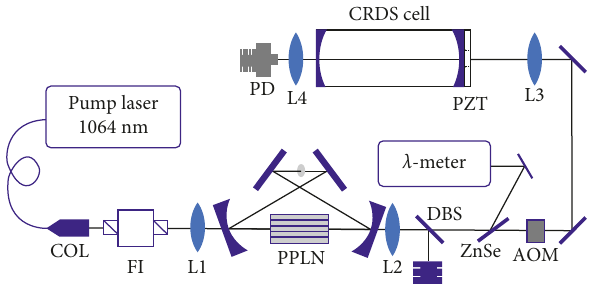
Figure 1: Schematic of the singly resonant cw OPO and CRDS spectrometer. The output of the seed fibre laser is amplified up to maximum 10.5W and coupled into the OPO cavity. Part of the idler is directed to a wavelength meter, and the rest is directed via an acoustical optical modulator (AOM) to the cavity ring-down measurement cell.